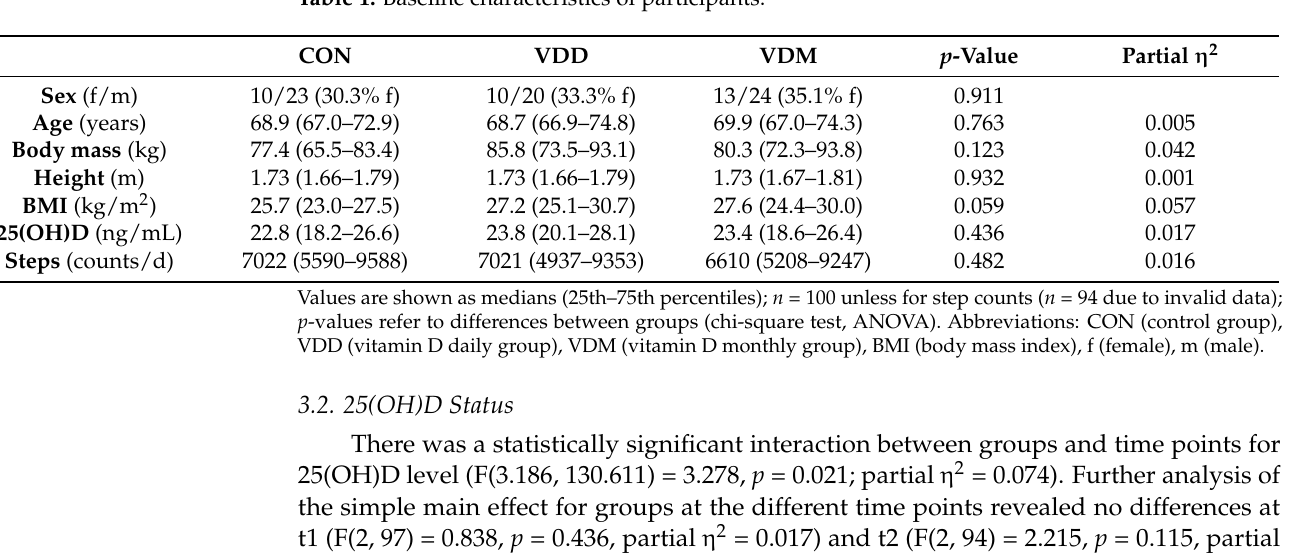
Table 1. Baseline characteristics of participants.